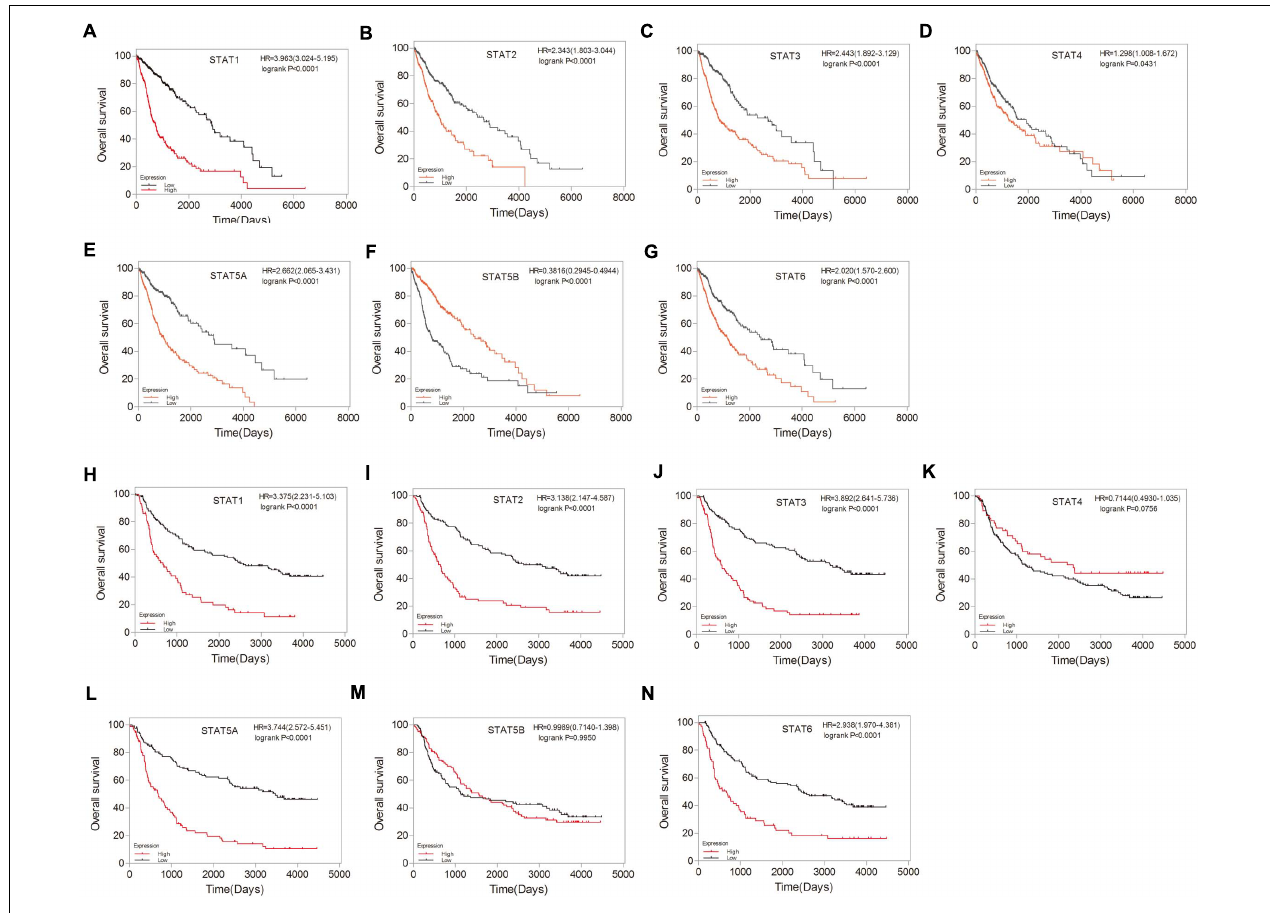
FIGURE 5 | Prognostic values of STATs in glioma. (A–G) Prognostic significance of individual STAT genes in glioma using TCGA database. (H–N) Survival curves of individual STAT genes in glioma using CGGA